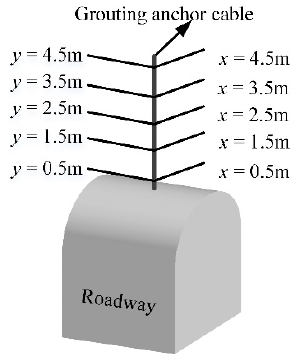
Figure 6. Cut-off diagram of diffusion length of grout.